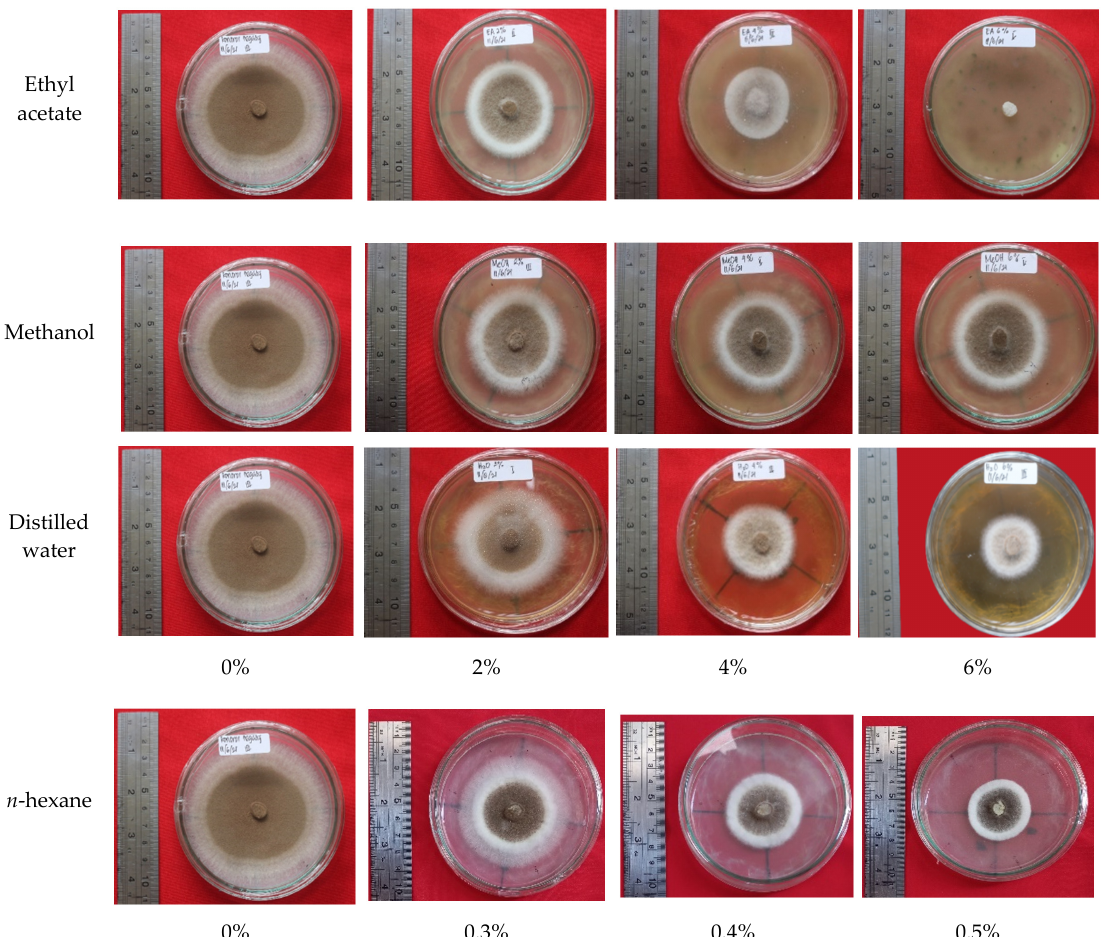
Figure 4. The growth of the A. foetidus fungus colonies after 7 d of incubation on PDA medium treated with different fungus-comb extracts at different concentrations.